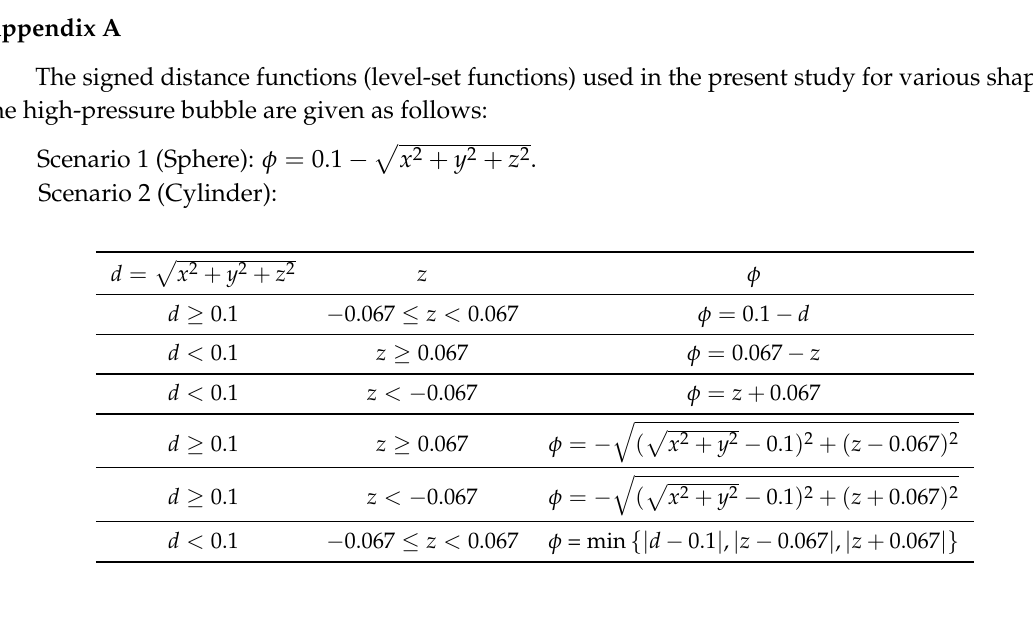
Figure S1: The initial setup of the 1-D simulation of the gas shock impacting on the gas-water interface, taken after [32], Figure S2: The distribution of velocity, pressure and density along x direction after 350 time steps of computations by using the present 3-D model, Figure S3: The initial configuration of the 2-D double underwater explosion simulation, taken after [34], Figure S4: The evolutions of the pressure field of the 2-D validation case at different time points by using the 3-D model, Figure S5: The temporal evolution of the pressure field for an initially bullet-like bubble in slice plots ( y = 0) (Scenario 4); mesh size: (left) 61 × 61 × 61; (right) 81 × 81 × 81, Figure S6: The pressure history recorded at the boundaries of the computational domain for an initially bullet-like bubble (Scenario 4); mesh size: (left) 61 × 61 × 61; (right) 81 × 81 × 81, Figure S7: The distribution of pressure along the x direction ( y = 0 and z = 0) (Scenario 1), Figure S8: The time-dependent curves of pressure recorded at the left and right boundaries of the computational domain (Scenario 1), Table S1: The initial values of